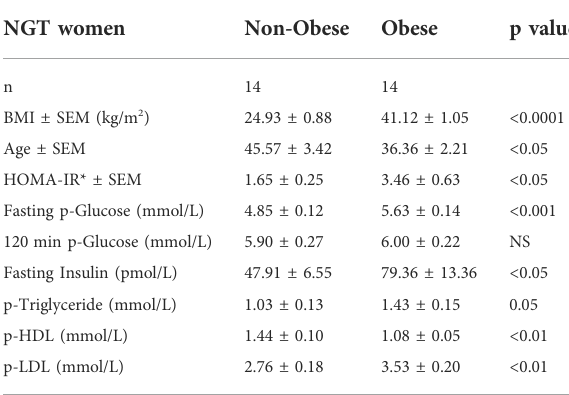
TABLE 1 Subject characteristics of normal glucose tolerant (NGT) non-obesewomen(BMI < 30 kg/m 2 )andwomenlivingwithobesity (BMI > 35 kg/m 2 ) undergoing laparoscopic cholecystectomy or gastric by-pass operation. Data are mean ±SEM (standard error of the mean). BMI, Body Mass Index; HDL, High Density Lipid; HOMA-IR, Homeostasis Model Assessment Insulin Resistance; p, plasma; LDL, Low Density Lipid. The two groups were compared using unpaired t-tests, p < 0.5 was considered signi fi cant. Clinical data was unavailable for some of the subjects. For three subjects from the group with obesity, some clinical data were missing including p-insulin, 120 min p-glucose, HOMA-IR and BMI. For one subject with obesity, p-HDL, p-LDL, p-triglyceride and fasting p-glucose data were missing. For one non-obese subject fasting p-glucose and HOMA-IR data were